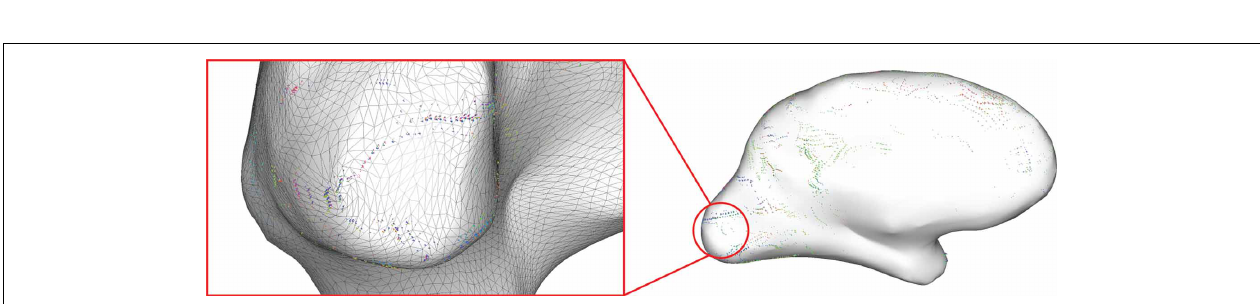
FIGURE 5 | After painting an area of interest (Left), anatomical background glyphs for an area-of-interest can be displayed. They can either show color-mapped values on their surface ( Top right ), or serve to support the simplified glyphs ( Bottom right ).